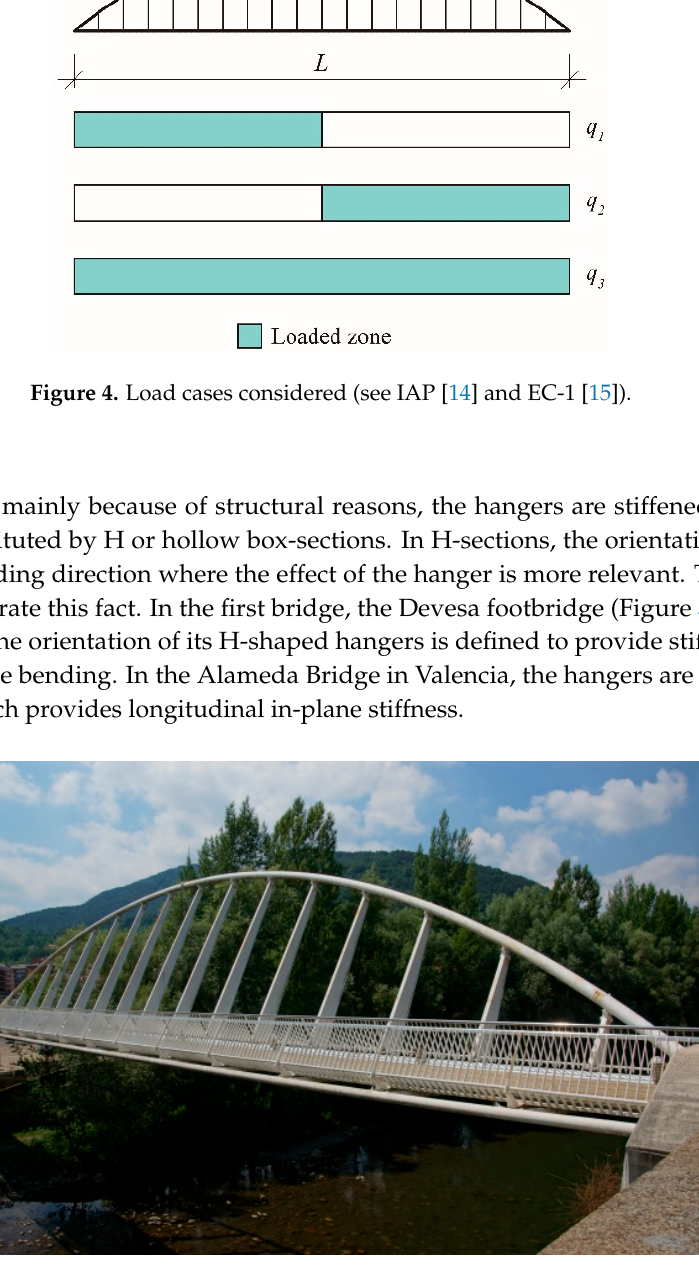
Figure 5. La Devesa footbridge (See Tzonis ([17] and Jorquera-Lucerga [18]) Photo: N, Janberg (reproduced with permission from Structurae [7], 2011).